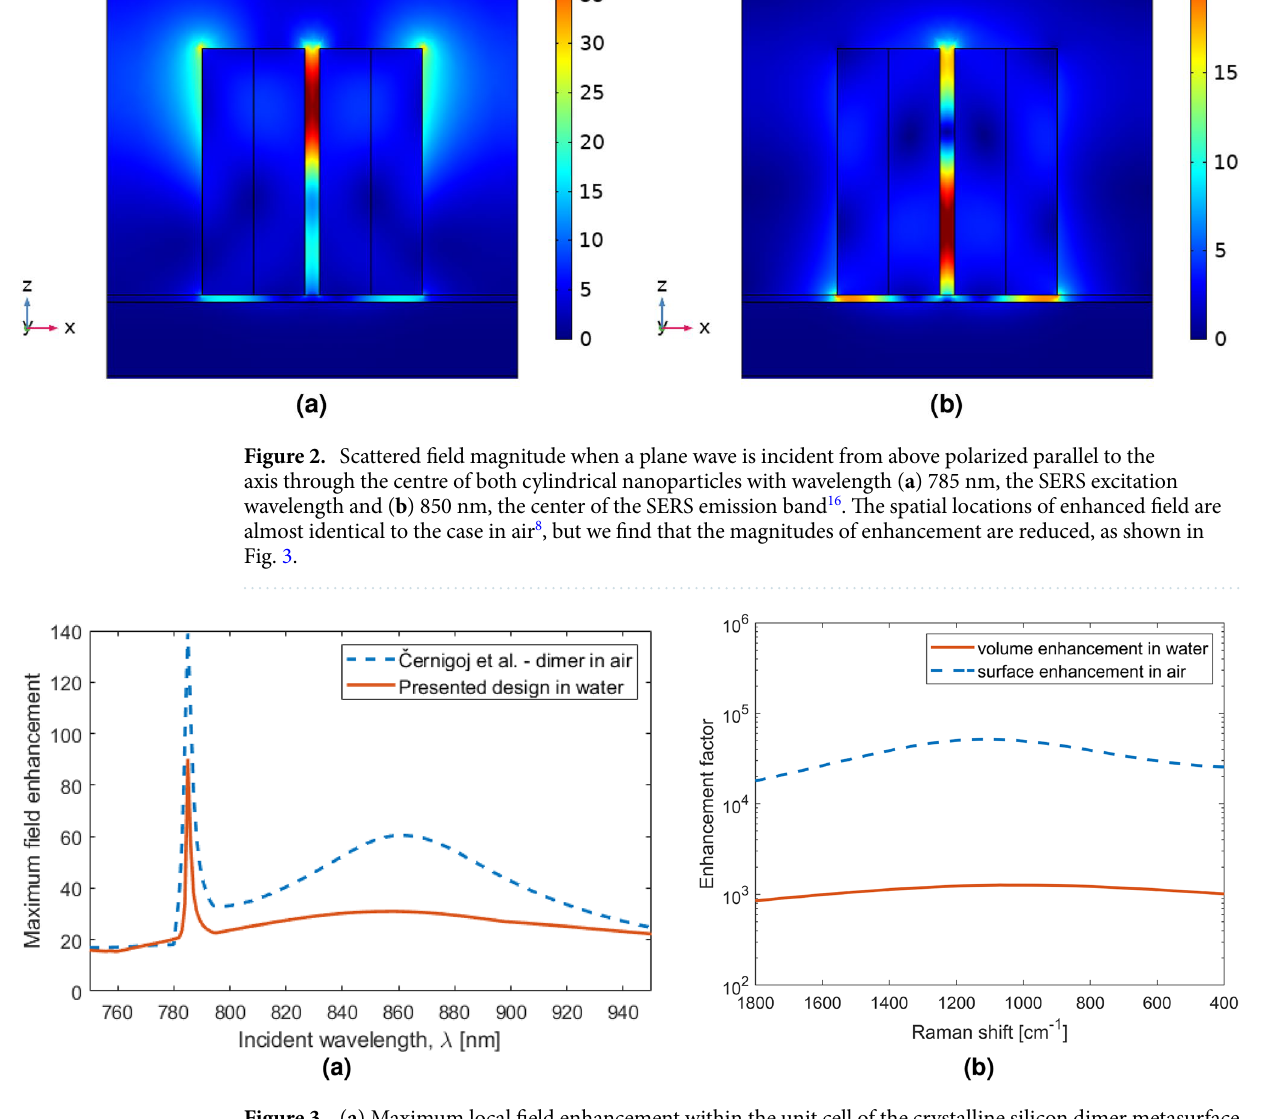
(785 nm), and broad resonance around 850 nm in the SERS emission wavelength region. The maximum field enhancement occurs in the hotspot between the nanodimers: the results for the array immersed in water is shown